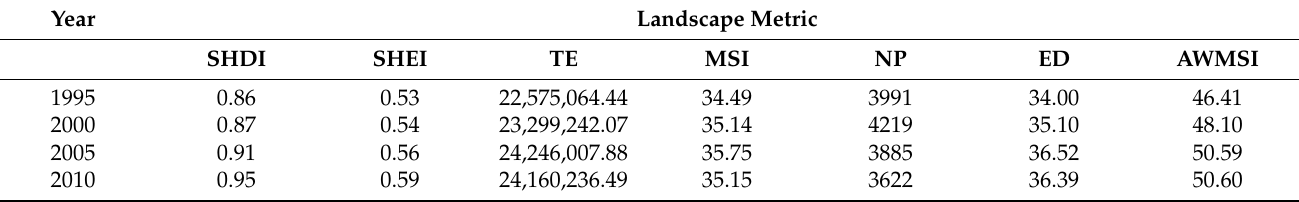
Table 4. Landscape metric changes within Shanghai between 1995 and